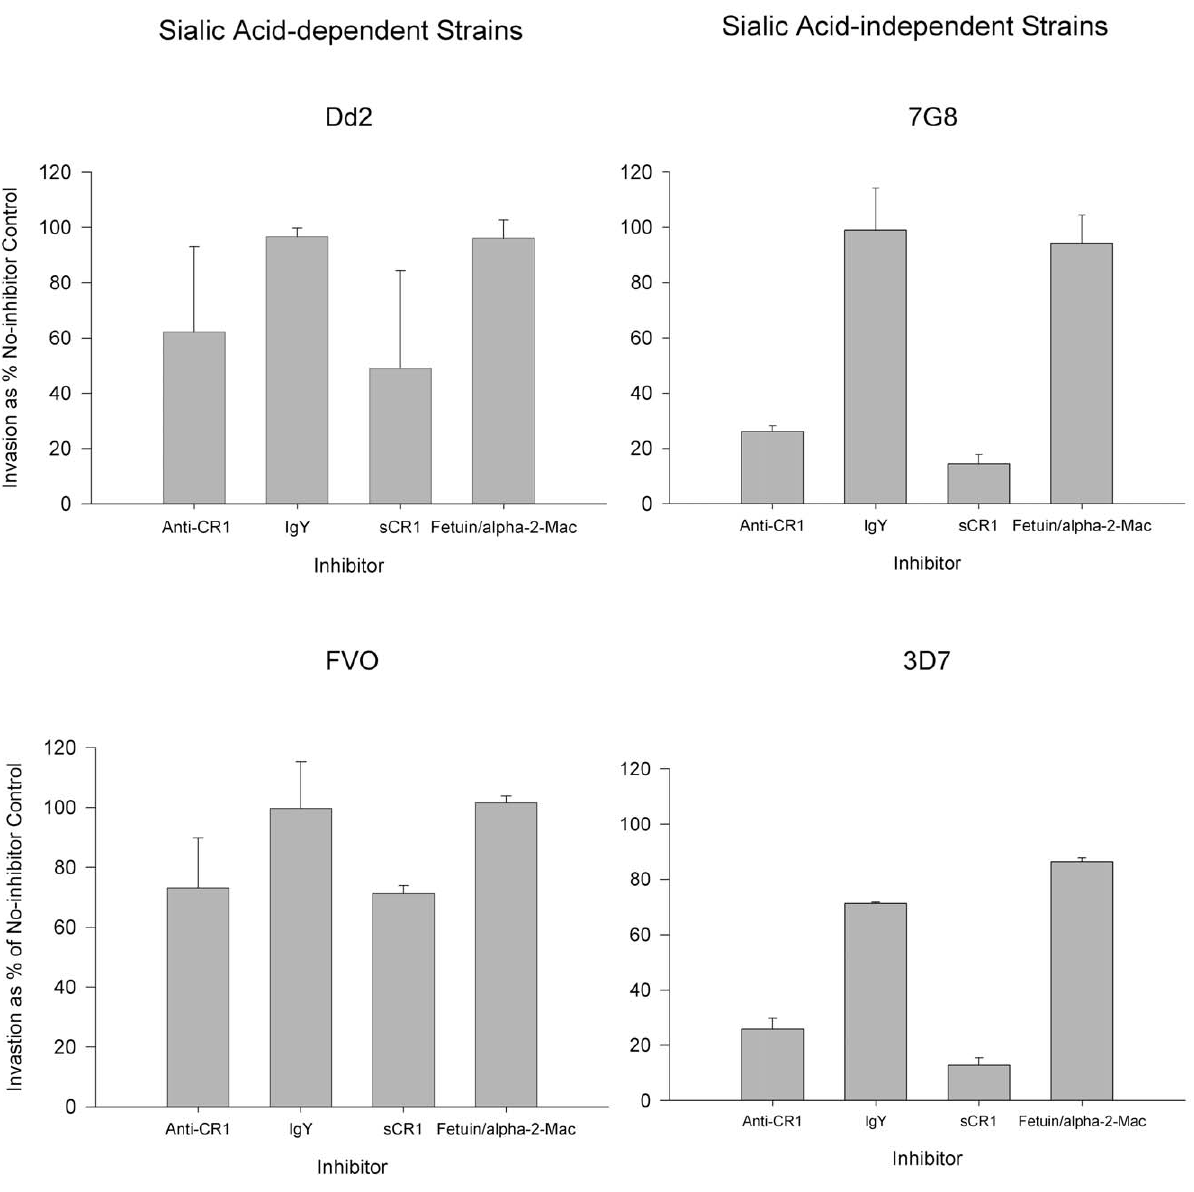
Figure 9. Inhibition of invasion of neuraminidase-treated red cells by sialic acid-dependent and independent strains. Bars represent means 6 standard deviations of the invasion as % of the no-inhibitor control. The figure represents a summary of 2–4 experiments. Parasitemias were determined by flow cytometry.